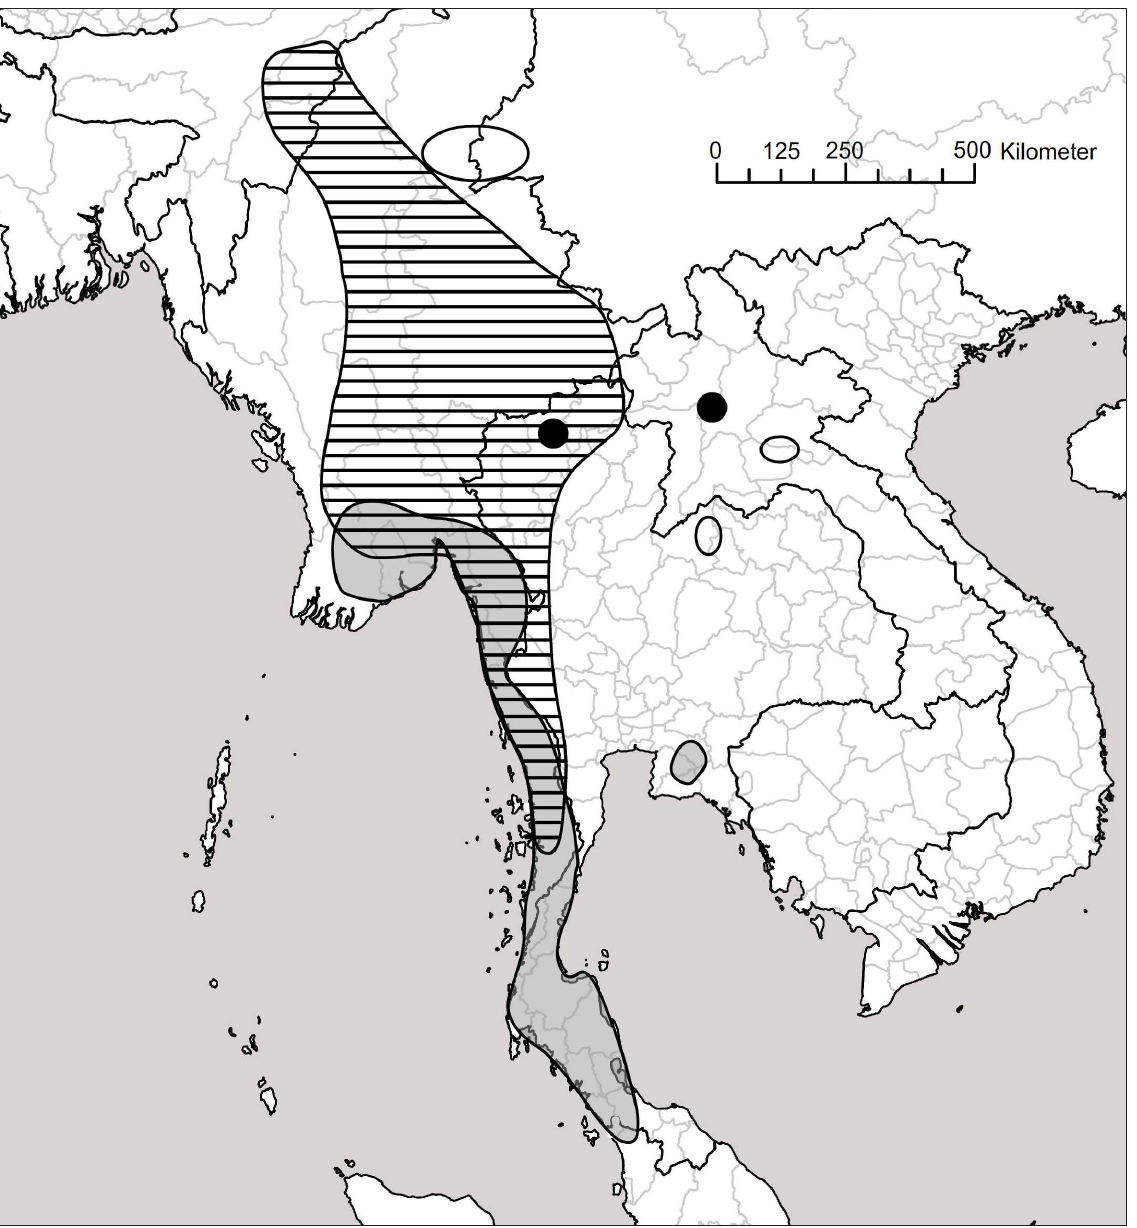
Fig. 4. Distribution of the genera Chersaecia Gude, 1899 (ruled area), Hunyadiscus Páll-Gergely, 2016 (white area), Naggsia Páll-Gergely & Muratov, 2016 (black circles) and Plectopylis Benson, 1860 (grey shaded